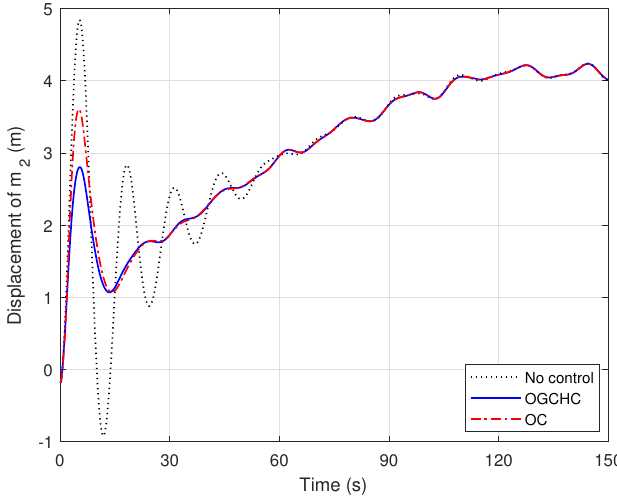
Figure 8. Displacement 2 of the riser without control, with OC and OGCHC under case II.